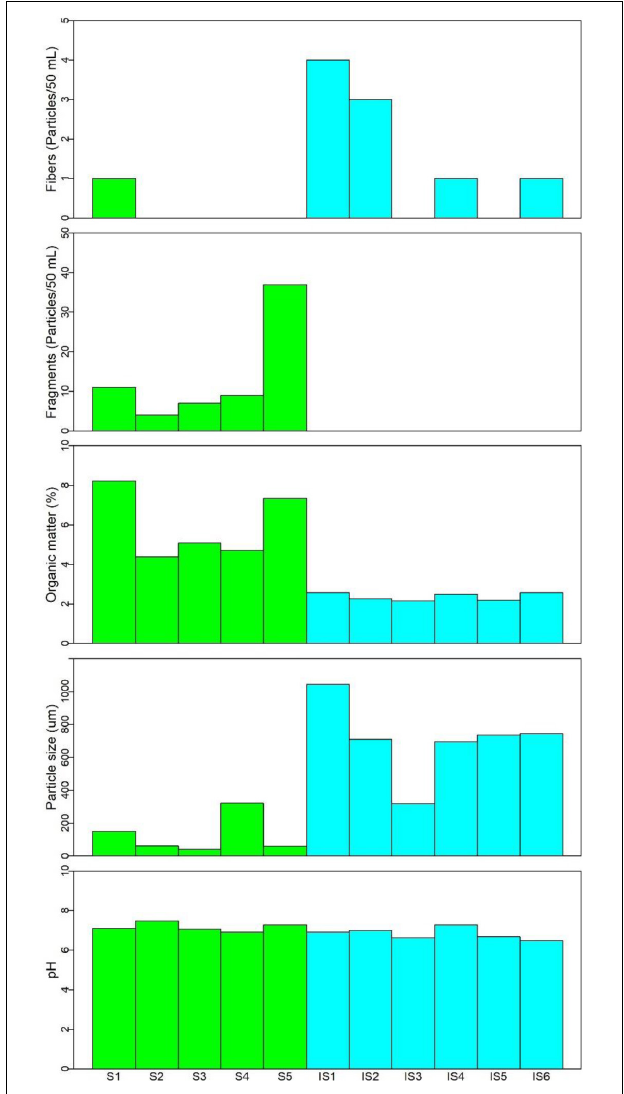
FIGURE 2 | The abundance of microplastics (i.e., fibers and fragments) and determination of an organic matter, particle size, and pH in soils (i.e., S1–S5) and intertidal sediments (i.e., IS1–IS6) of Fildes Bay,